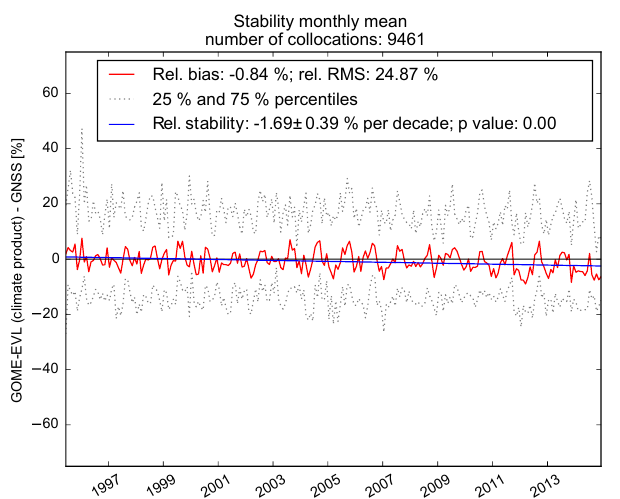
Figure 14. Time series of the relative difference between TCWV monthly means from the Climate product and ARSA stations. Only stations which were available for the whole time period are consid-